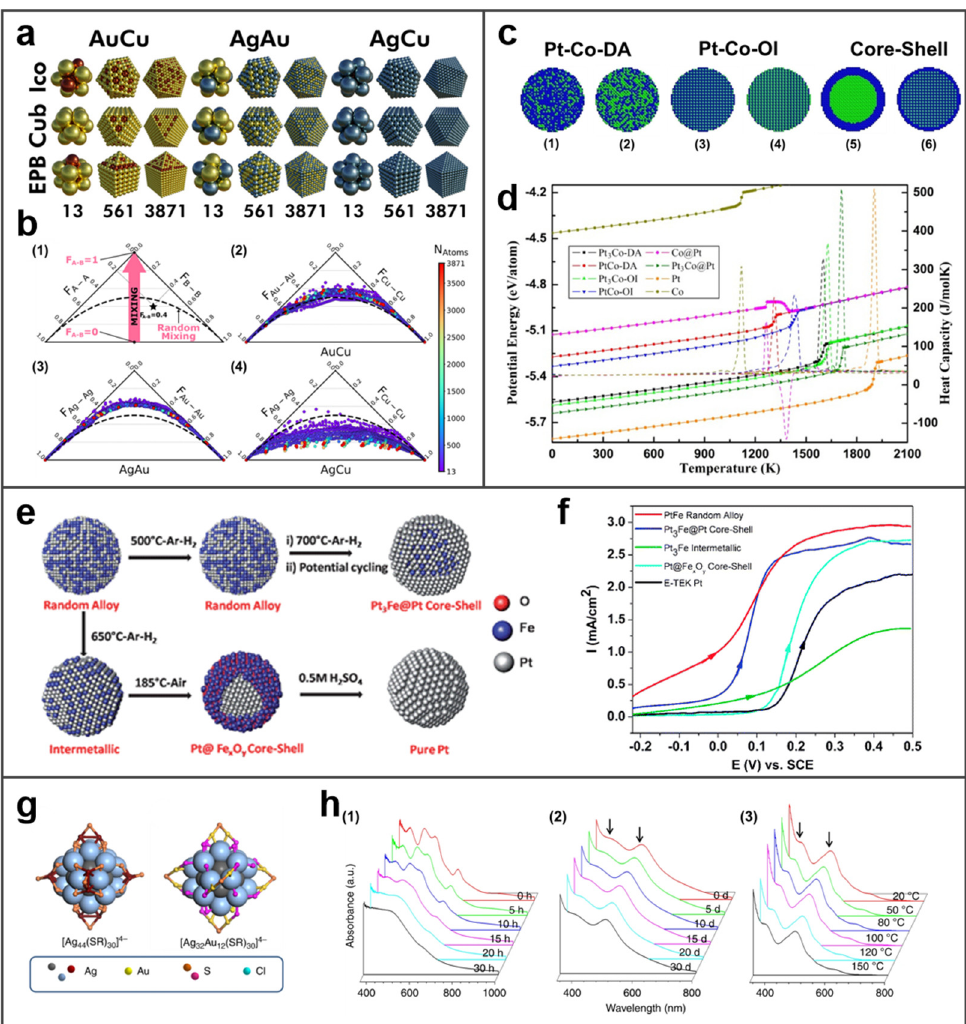
Figure 6. The stability of BMNs. ( a ) The most stable chemical ordering and composition at the given size, shape, and metal pair. Reprinted with permission from Ref. [101]. ( b ) Bond composition plots: (1) guiding plot illustrating the theoretical mixing limits from no heteroatomic bonds (F A − B = 0) to no homoatomic bonds (F A − B = 1); (2) (3) and (4) the preferential compositions of AuCu, AgAu, and AgCu NPs at all sizes and structures in thermodynamics. Reprinted with permission from Ref. [101]. Copyright © 2020 American Chemical Society. ( c ) Schematic illustration of Pt–Co bimetallic NPs: (1) disordered Pt 3 –Co alloy (Pt 3 Co-DA), (2) disordered Pt–Co alloy (Pt–Co–DA), (3) ordered Pt 3 Co L12 intermetallics (Pt 3 Co–OI), (4) ordered PtCo L10 intermetallics (PtCo-OI), (5) Co–Pt core–shell structure (Co@Pt), and (6) Pt 3 Co–Pt core–shell structure (Pt 3 Co@Pt). Coloring denotes the type of atom: blue, Pt atom; green, Co atom. Adapted with permission from Ref. [103]. ( d ) Temperature dependence of potential energy and specific heat capacity for different Pt–Co bimetallic NPs (the dashed lines correspond to the heat capacity). Reprinted with permission from Ref. [103]. Copyright © 2017 American Chemical Society. ( e ) Pt–Fe bimetallic NPs with different architectures. Reprinted with permission from Ref. [104]. ( f ) Polarization curves on different Pt-Fe catalysts. Reprinted with permission from Ref. [104]. Copyright © The Royal Society of Chemistry 2011. ( g ) Structures of Ag NCs and Ag@Au NCs (the hydrocarbon tails and carboxylic groups of the protecting ligands are omitted). Reprinted with permission from Ref. [105]. ( h ) UV absorption spectra of (1) [Ag 44 (SR) 30 ] 4 − and (2), (3) [Ag 32 Au 12 (SR) 30 ] 4 − NCs (The arrows indicate the absorption features at 390 and 490 nm). Reprinted with permission from Ref. [105]. Copyright © 2022 Springer Nature Limited.